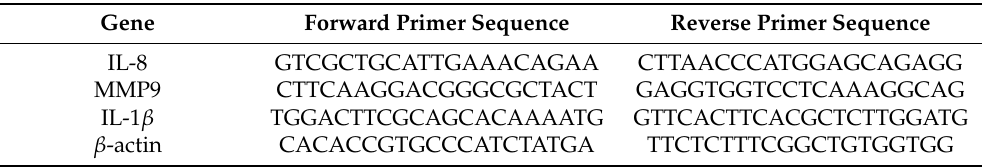
Table 2. Primer information of